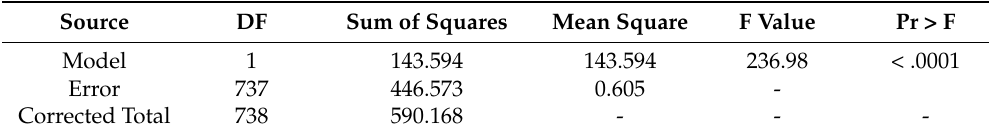
Table 17. ANOVA table for root